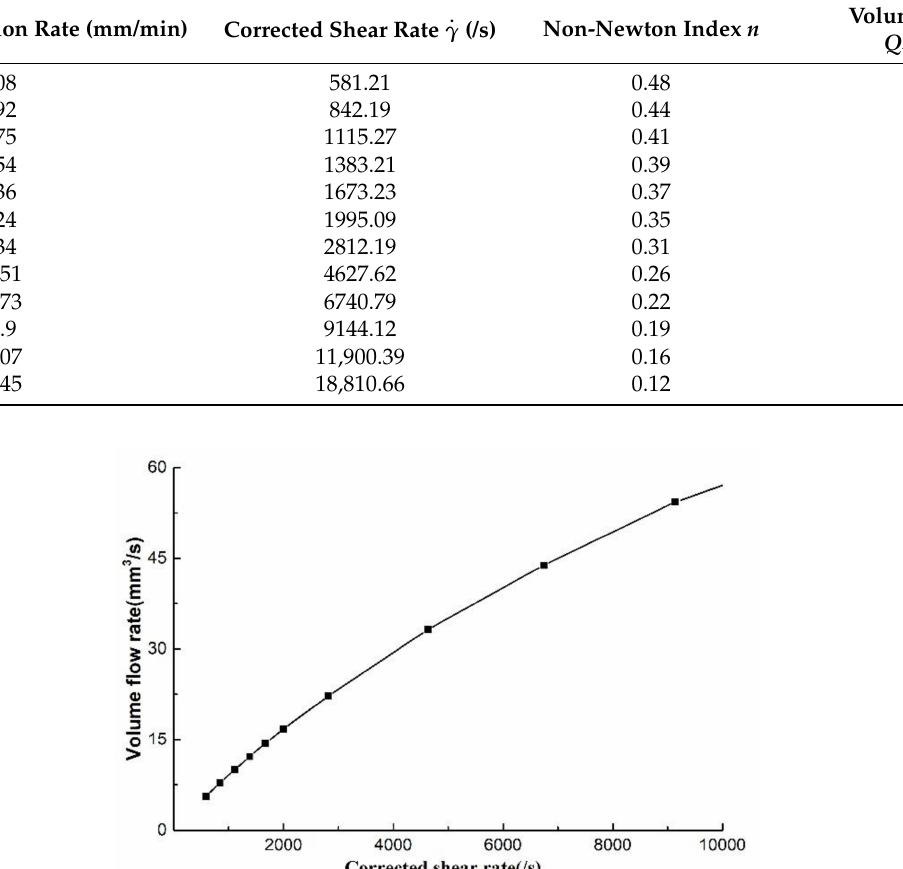
( c ) Figure 7. Cross section of micro tubes at different screw speeds: ( a ) Screw speed = 1 r/min; ( b ) Screw speed = 5 r/min; ( c ) Screw speed = 8 r/min. There are two main reasons for the increase of microtubule outer diameter and wall thickness. On one hand, the increase of the screw speed leads to the increase of the melt volume flow rate, then the shear rate increases. For a pseudoplastic fluid, extrusion swell- ing ratio usually increases with the increase of the shear rate before melt fracture in the extrusion process [19]. Therefore, outer diameter and wall thickness increase with the in- crease of the screw speed. On the other hand, according to the continuity theorem: 0 0 V S V S × = × (14) where 0 V and